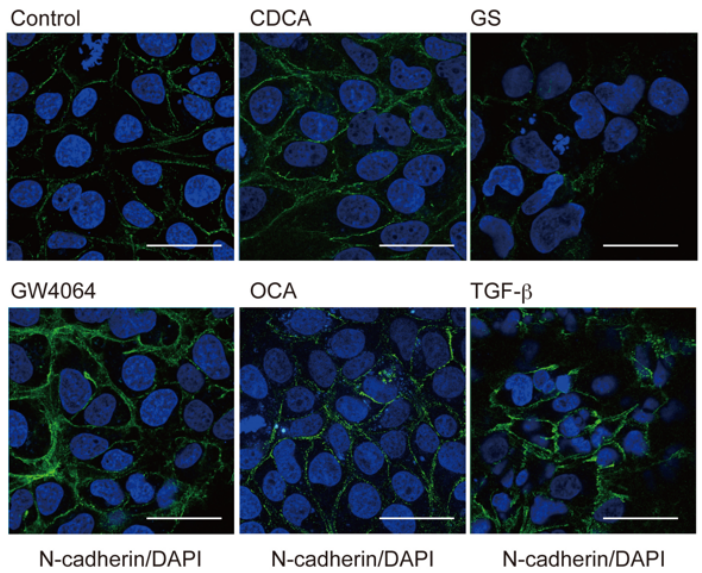
Figure 2. FXR activation induces N-cadherin expression in HuH-7 cells. Cells were treated with vehicle control (Cont), 100 μM CDCA, 32 μM GS, 10 μM GW4064, 10 μM OCA, or 10 ng/mL TGF-β for 48 hours and stained for N-cadherin ( green ) and DAPI ( blue ). Scale bar, 50 μm.